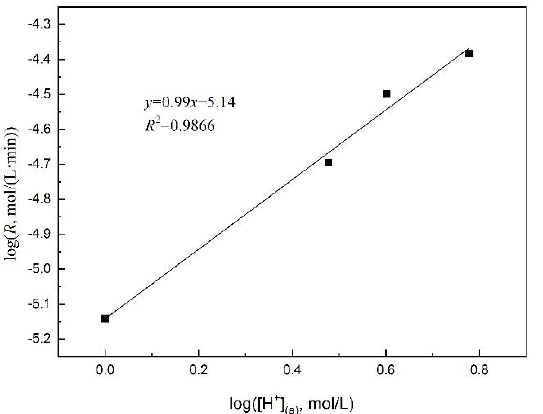
Figure 7. Effect of HCl concentration in stripping agent on the stripping rate (experimental condi- tions: Ce 4+ concentration in organic phase 0.02 mol/L, HEH/EHP concentration 0.2 mol/L, c (H 2 O 2 ) (a) : c (Ce) (o) 2:1, temperature 25 °C and stirring speed 300 r/min).